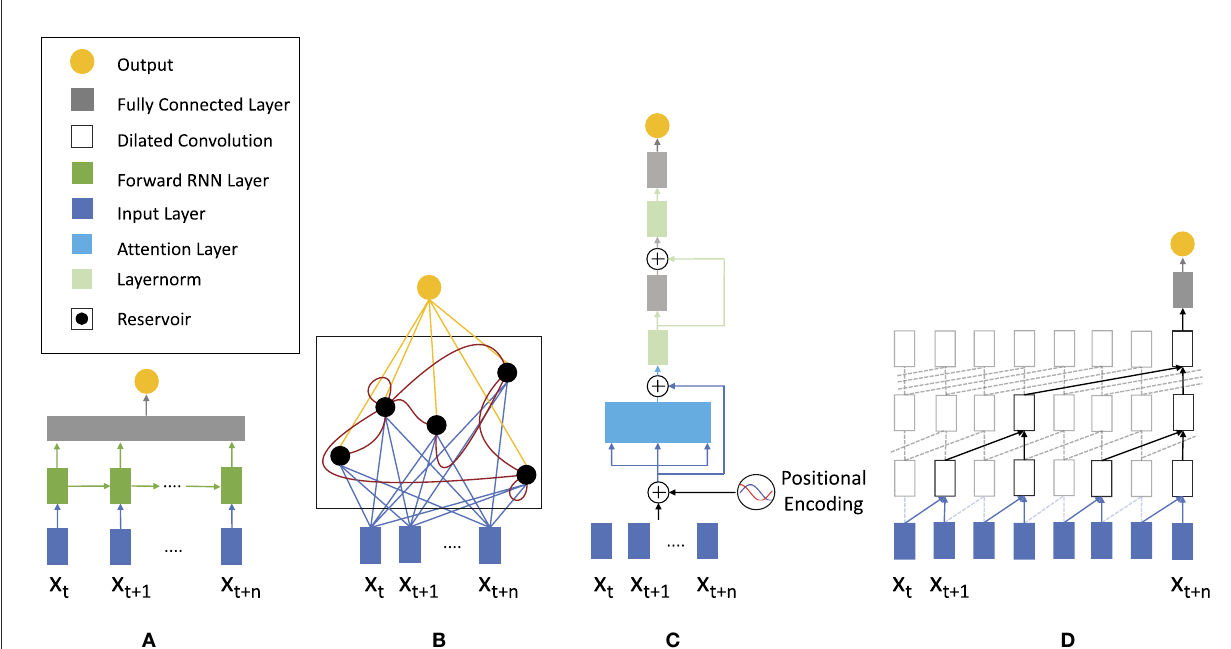
FIGURE3 Neural network architectures applicable for analyzing time series: (A) traditional recurrent neural network (RNN) consisting of an input layer (blue), a forward layer (green), and a fully interconnected layer, (B) recurrent echo state network, (C) feed-forward transformer architecture utilizing attention for time series analysis, and (D) temporal convolutional neural network (TCN) using dilated convolutions.